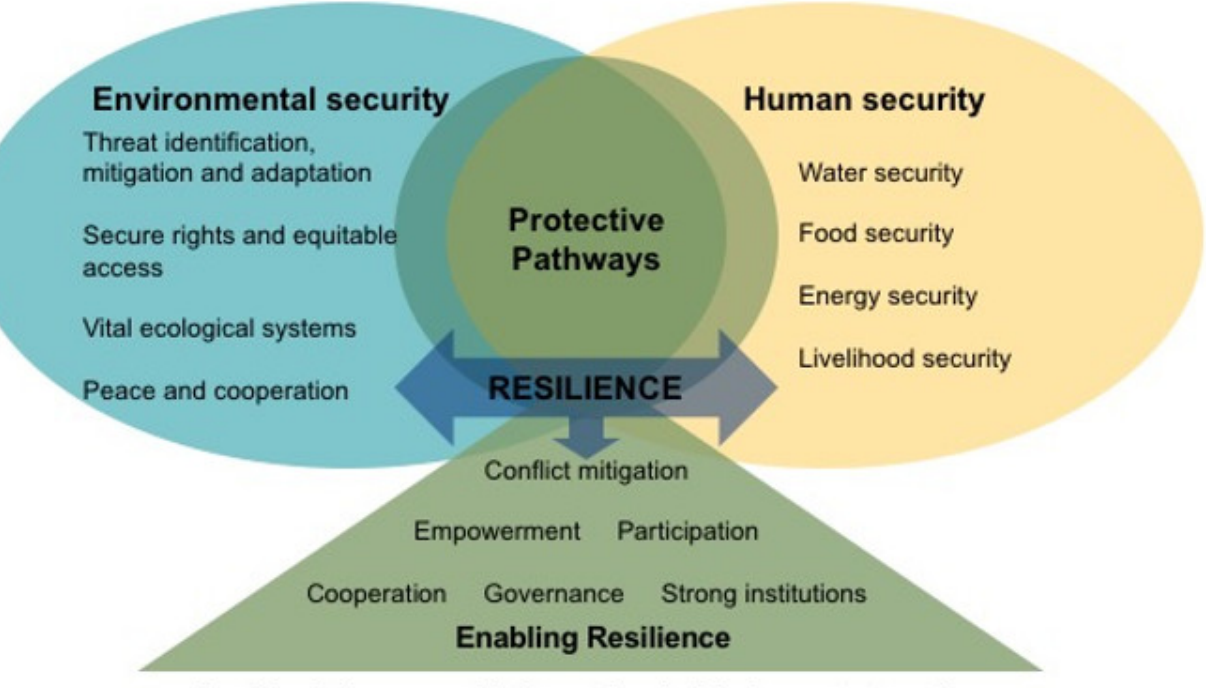
Figure 1. Protective pathways frame for identifying relationships between environmental protection, human security and conflict.